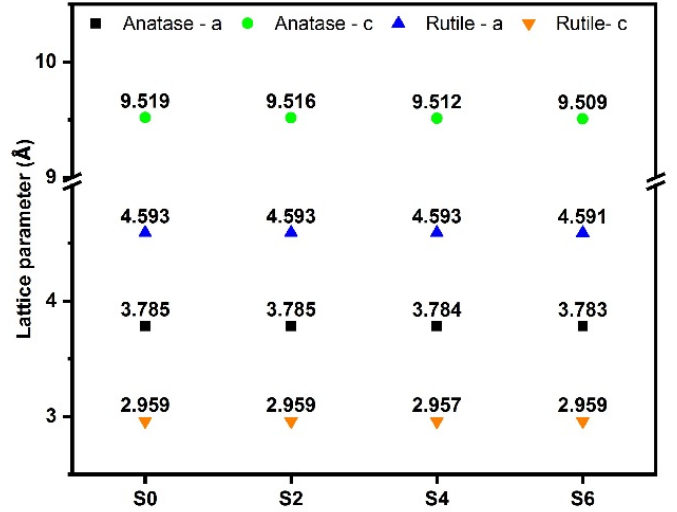
Figure A1. Lattice parameters a and c of the anatase and rutile phases for samples S0, S2, S4 and S6.